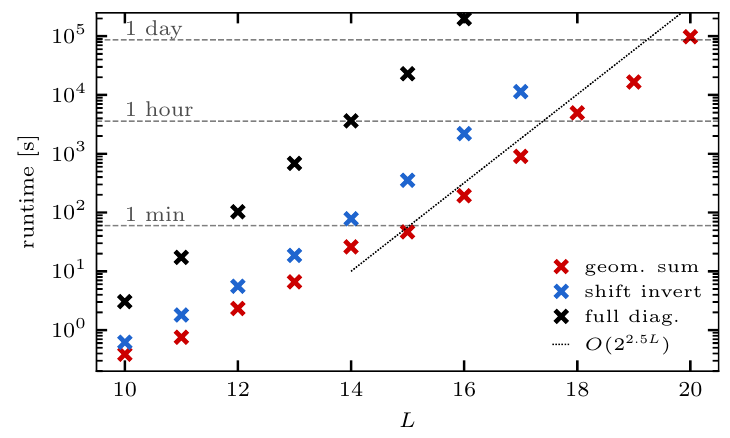
= 50 eigenpairs close to ev